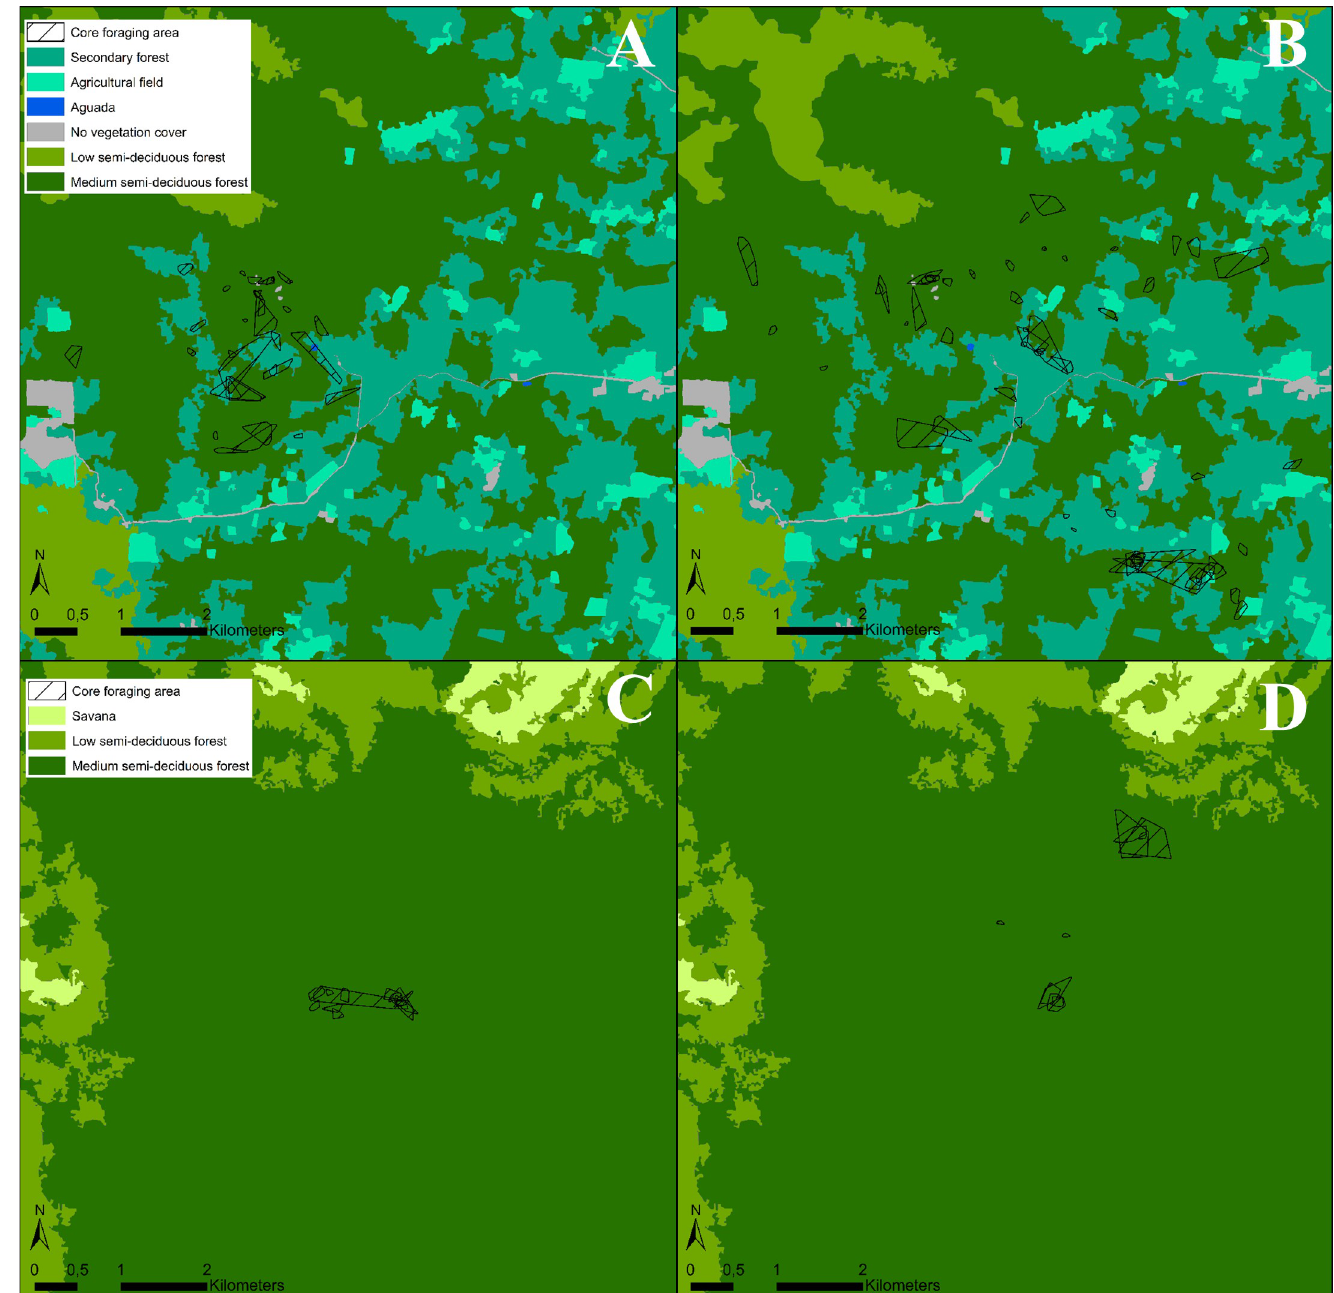
Fig 2. The core foraging ranges per night flight of two females (A) and four males (B) in the study site of Hormiguero and two female (C) and two males (D) in the study site of Monterrey. https://doi.org/10.1371/journal.pone.0220504.g002 Females were larger than males (rank-sum tests; mass: z = 2.286, p = 0.022; forearm: z = 2.027, p = 0.043; Table 1). The mean change in mass of the bats after placement of the GPS (Table 2) showed that the GPS-tagged bats did not tend to lose weight (mean change = +0.32, 95% CI = -2.1 to +2.9 g). The emergence times of bats were ambiguous since the GPS trackers